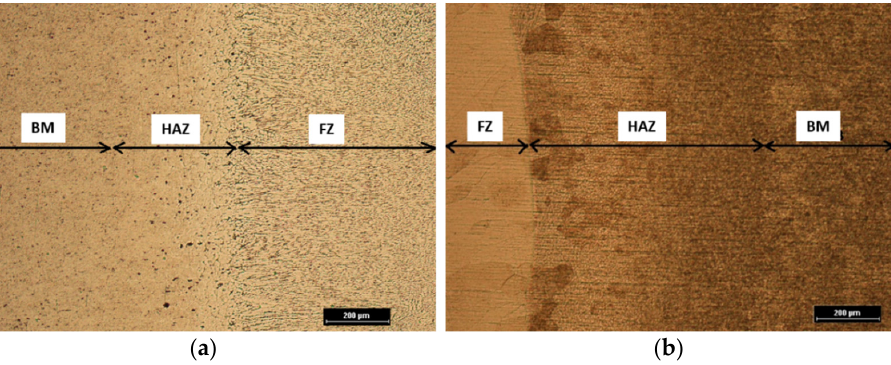
Figure 3. Optical micrographs showing microstructural evolution in the Al side ( a ) and Ti side ( b ).